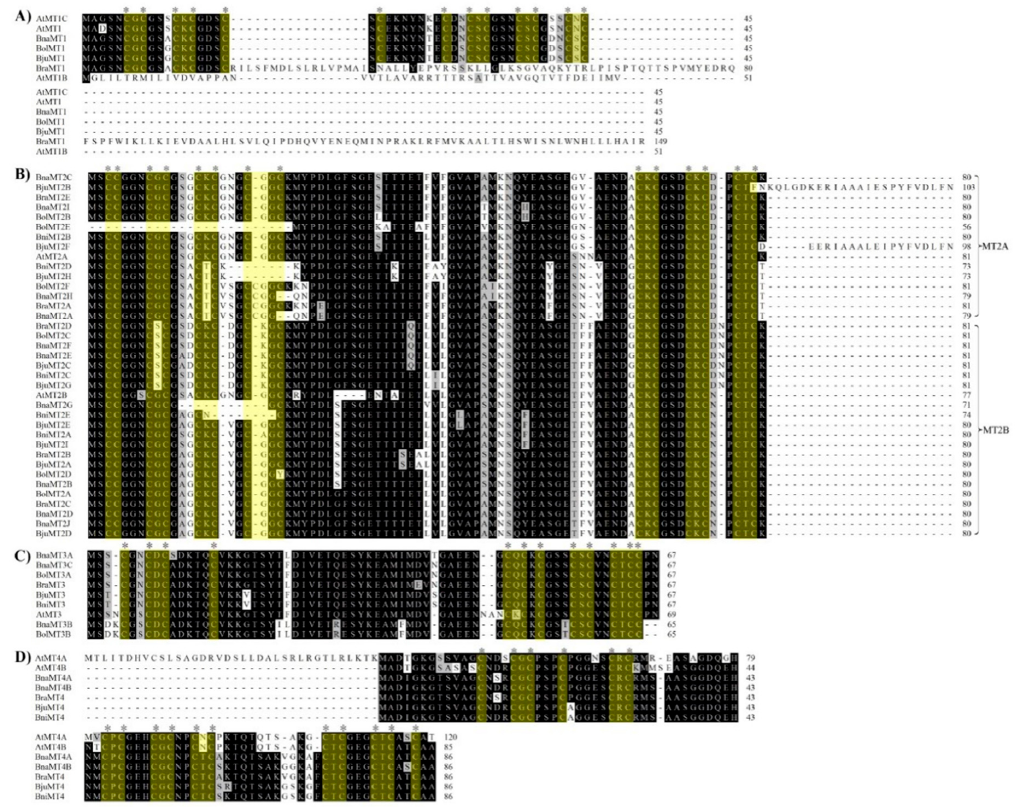
Figure 2. Alignment of MT protein sequences from A. thaliana and various Brassica species. Black and light gray shading indicate identical and conserved amino acid residues, respectively. ( A ) The MT1 protein sequences; ( B ) the MT2 protein sequences; ( C ) the MT3 protein sequences; (D) the MT4 protein sequences. The conserved cysteines regions are highlighted by asterisks and light yellow. The MTs were preliminarily classified by Cobbett and Goldsbrough reported [10]; detailed information is provided in Table 1.